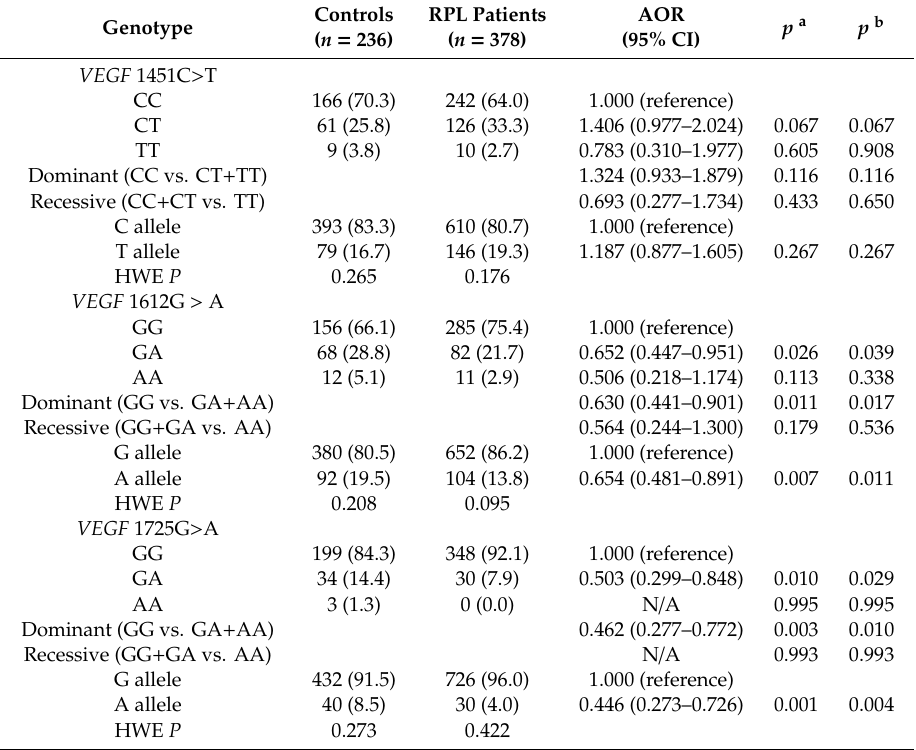
Table 2. Genotype frequencies of VEGF gene polymorphisms between controls and RPL patients.